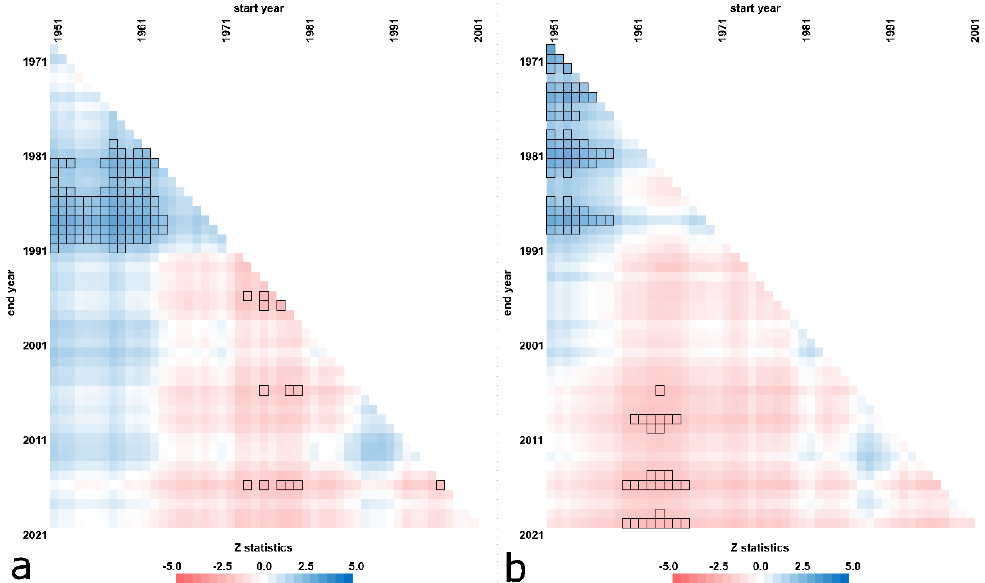
Figure 6. Multitemporal trend analysis of yearly mean flows (YM) for the Gwda ( a ) and Flinta ( b ) rivers (marked fields indicate statistically significant changes at the level 0.05).